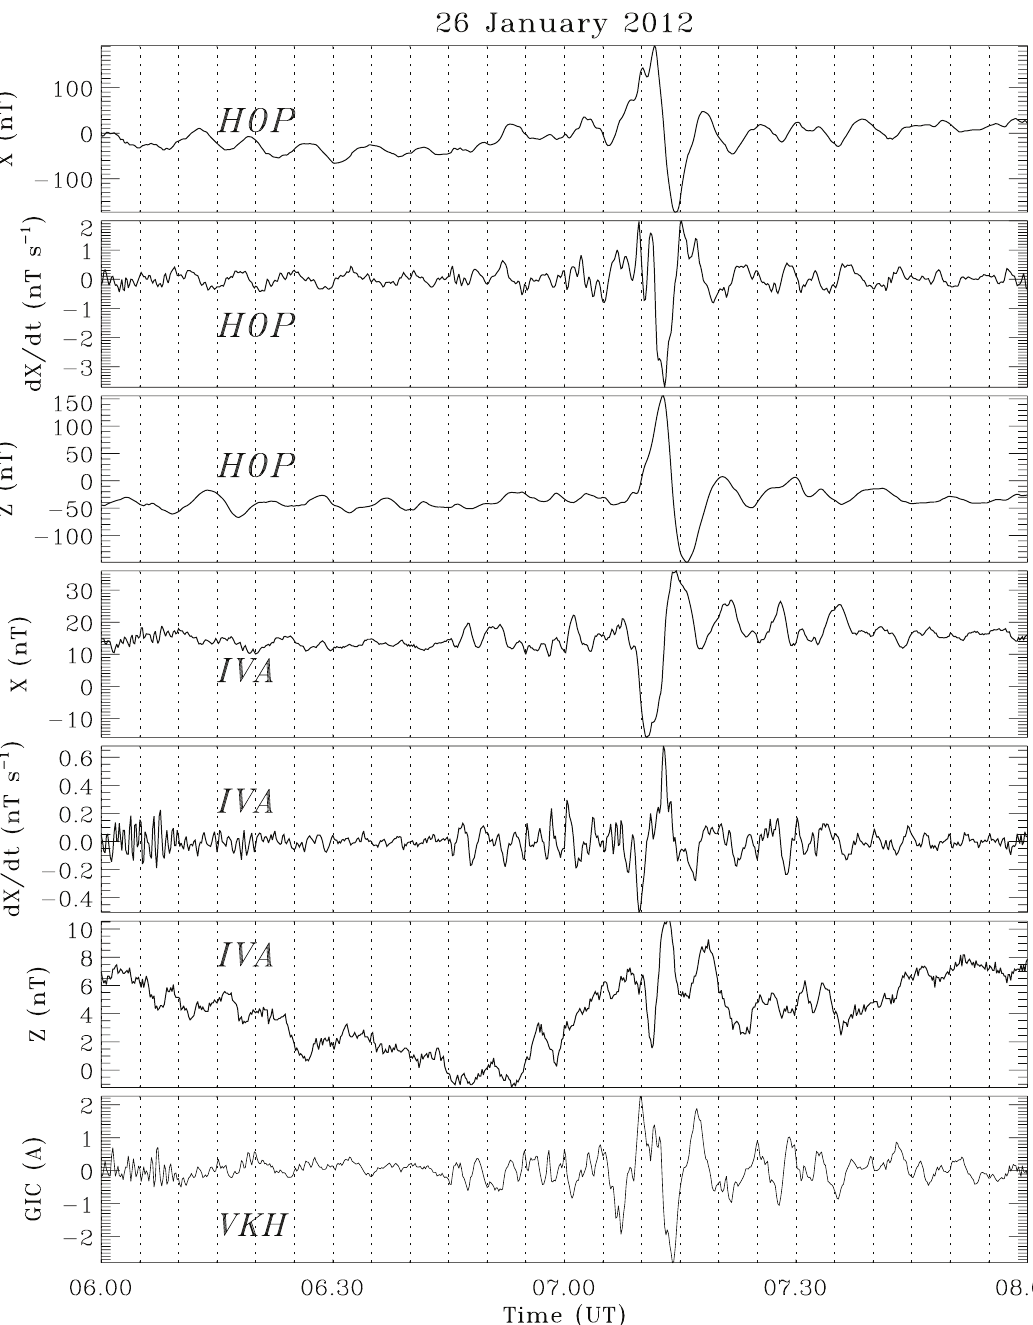
IVA (10-s data), and GIC [A] at VKH (10-s data) associated with the TCV between 06 UT and 08 UT on 26 January